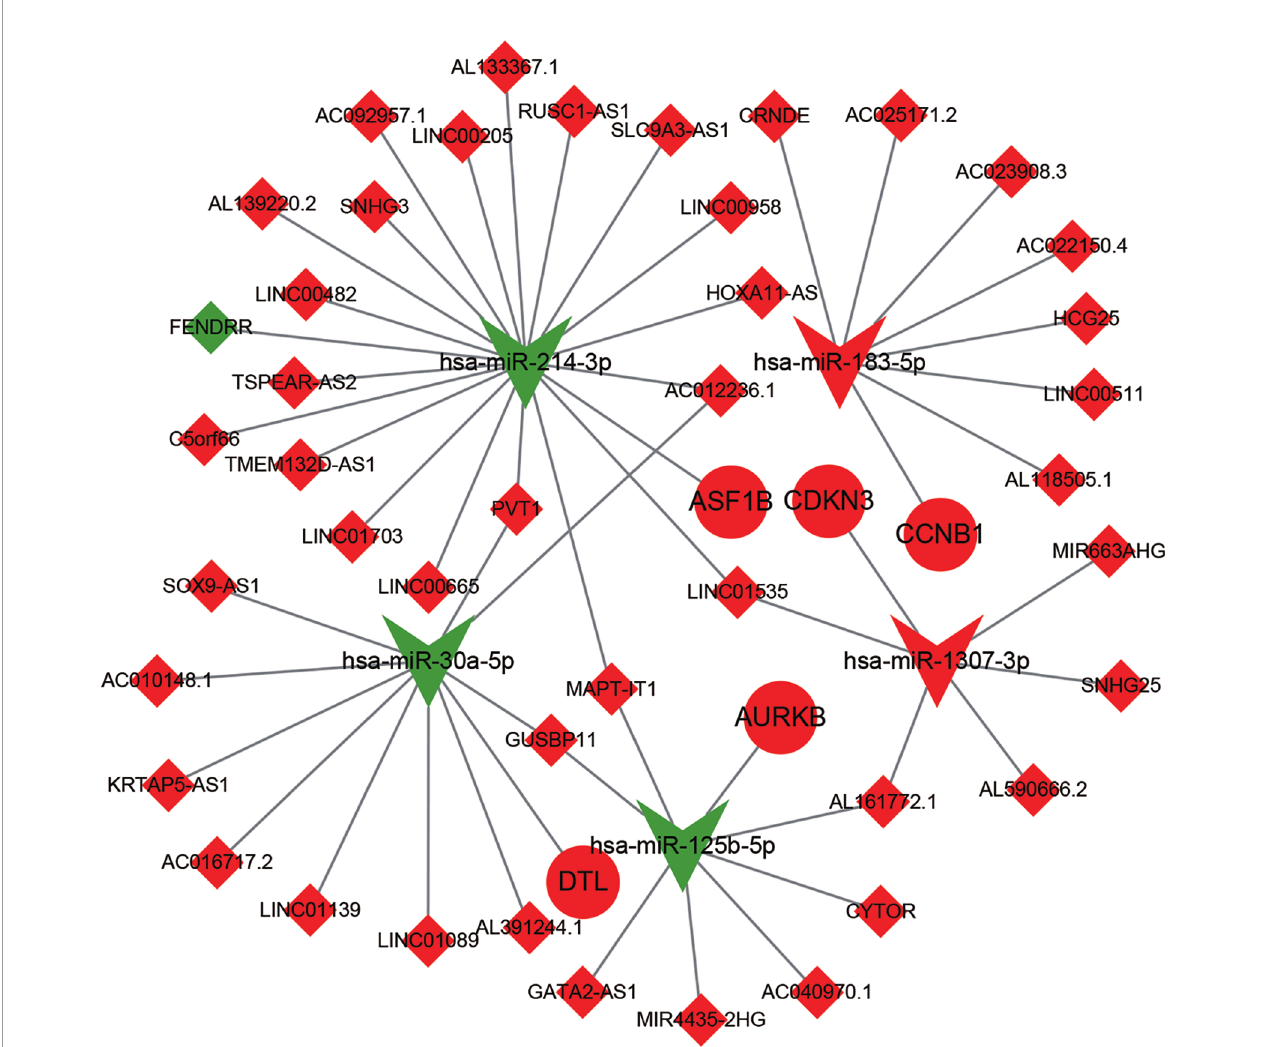
FIGURE 5 | The construction of ceRNA sub-network based on relapse-related DEMs. Red represent up-regulated; green represent down-regulated; diamonds represent lncRNA; balls represent mRNA; triangle represent